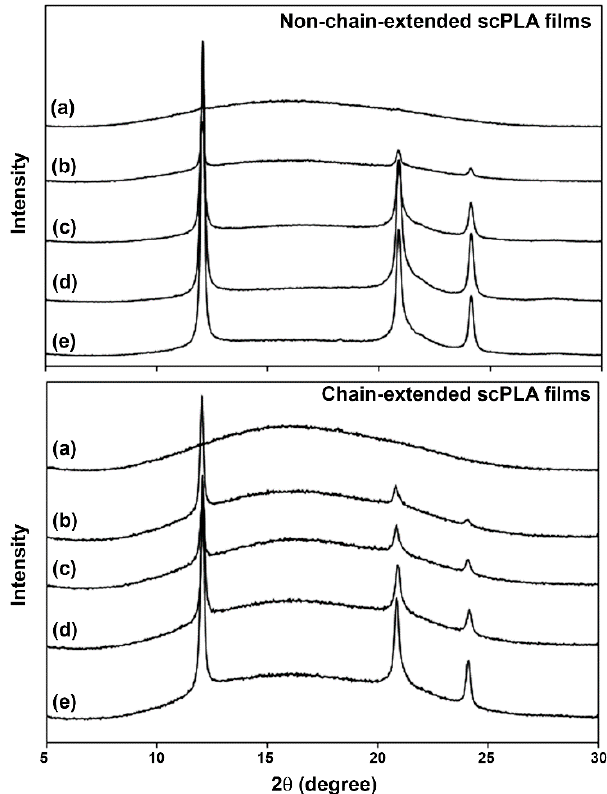
Figure 2. X-ray diffractometry (XRD) patterns of ( above ) non-chain-extended and ( below ) chain-extended scPLA films with PLLA/PDLA ratios of (a) 100/0, (b) 90/10, (c) 80/20, (d) 70/30 and (e) 60/40 ( w / w ).